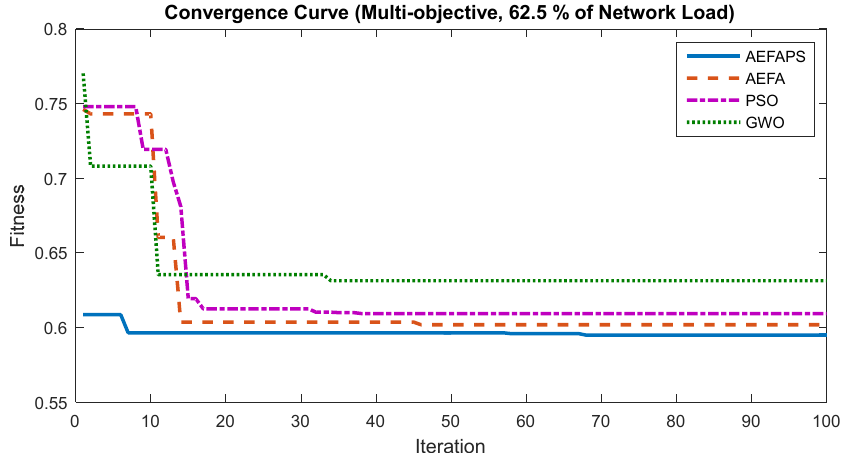
Figure 14. Convergence curve of the four methods in many-criteria reconfiguration of an unbalanced 33-bus network (62.5% of network nominal load). Table 5. The results of single-criterion and many-criteria reconfiguration of an unbalanced 33-bus network (62.5% of network nominal load).